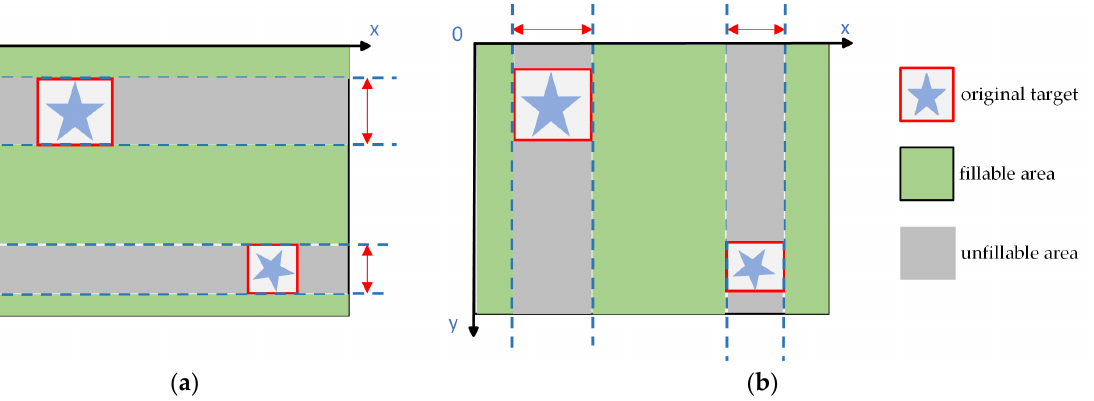
Figure 6. The one-dimensional non-overlapping filling area search: ( a ) Filling targets along the horizontal direction; and ( b ) filling targets along the vertical direction.